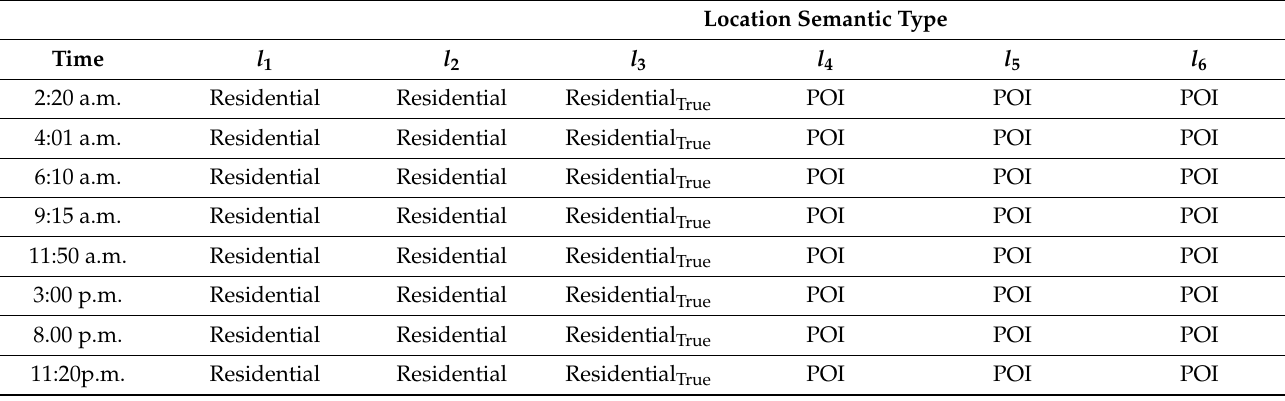
Table 2. Showing the semantic information associated with locations in sample LBS